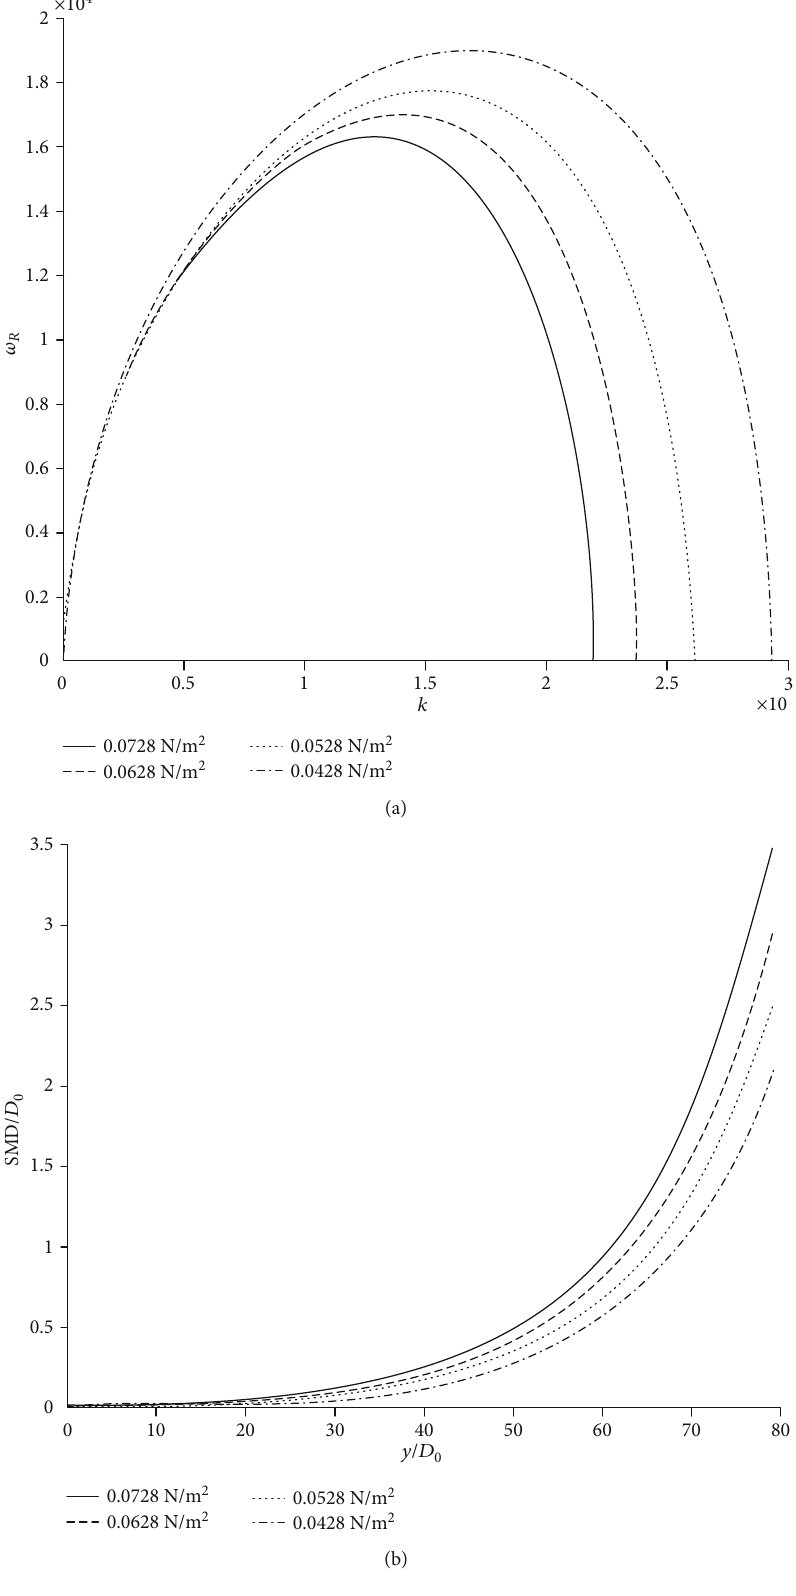
= 1 : 29kg/m 3 , ρ = 1000 kg/m 3 , u G g L